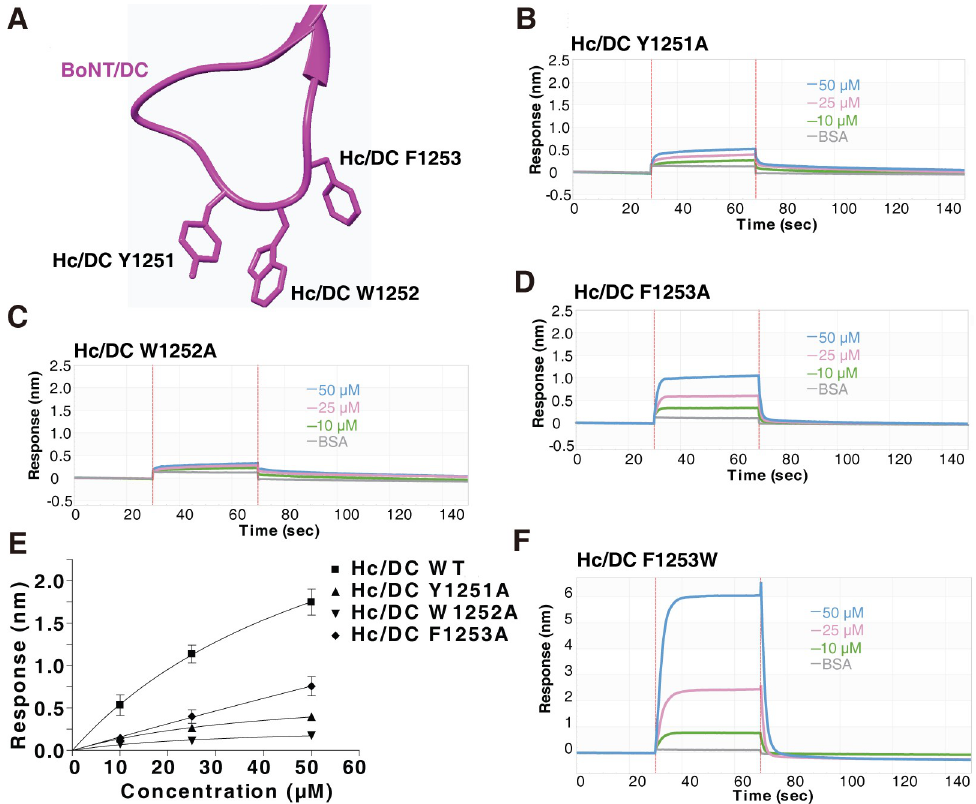
Fig 2. Mutating aromatic residues at the tip of H C /DC-LBL reduces its binding to lipid membranes. (A) Structure of the H C /DC-LBL showing the three aromatic residues at the tip. (B–D) Binding of H C /DC-LBL containing the indicated point mutations to ND1 was analyzed by BLI assays. Mutating the three aromatic residues at the tip of LBL reduced binding of H C /DC to ND1. (E) The maximal binding signals of H C /DC mutants as measured in panels B–D were averaged and plotted (mean ± SD, n = 3). Numerical values for (E) are available in S1 Data. (F) H C /DC-LBL (F1253W) showed robust binding to ND1. BLI, biolayer interferometry; BSA, bovine serum albumin; H C , C-terminal receptor-binding domain; LBL, lipid-binding loop; ND1, receptor-free nanodisc; WT, wild-type.